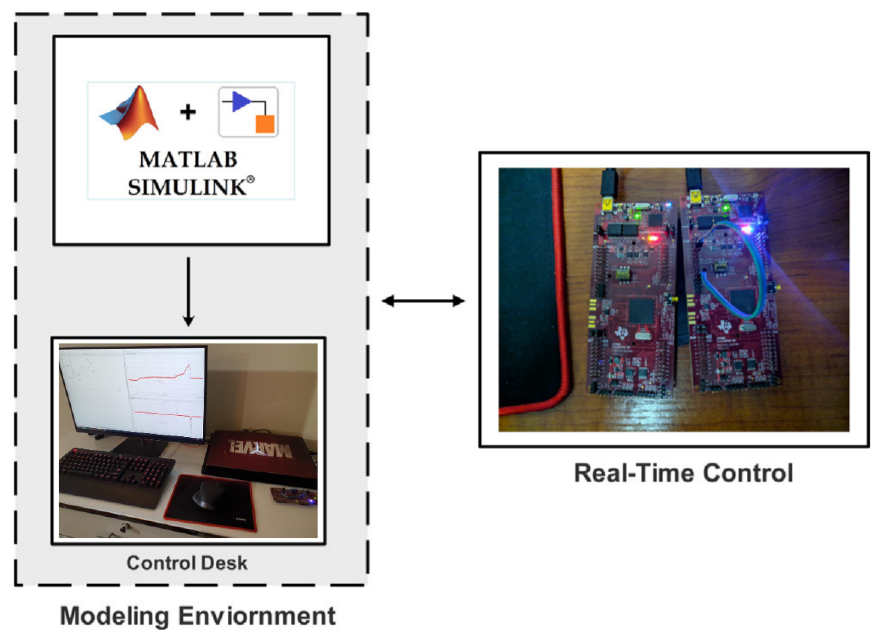
Figure 10. Hardware in the loop (HIL) setup.